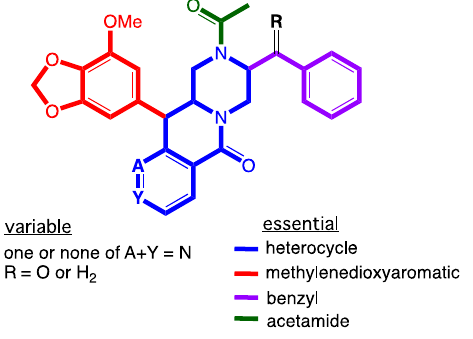
Figure 8. SAR analysis of the chrysosporazine P-gp inhibitory pharmacophore. Table 3. Ability of analytes 1 – 9 and 11 – 14 to reverse doxorubicin resistance in P-gp over-expressing human colorectal carcinoma cells (SW600 Ad300).